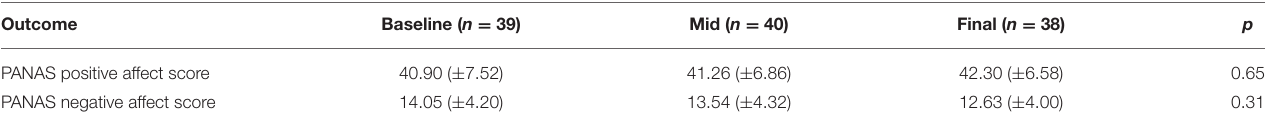
TABLE 8 | Changes in subjects’ emotional status throughout the entire training protocol using positive and negative affect scale (PANAS).